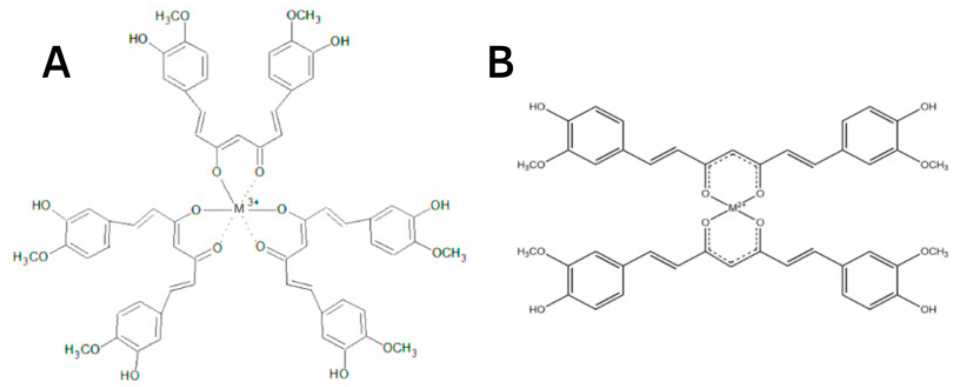
Figure 6. A simplified illustration of the CUR chelating trivalent metals in a 1:3 configuration ( A ) and bivalent metals in a 1:2 configuration ( B ) (adapted from Rainey et al. [94]).